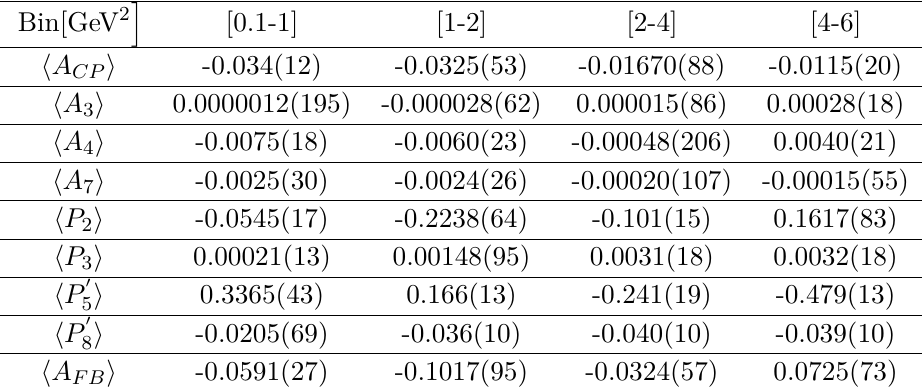
¯ B ( B ) → ρ 0 ‘‘ decays measurable only at Belle.